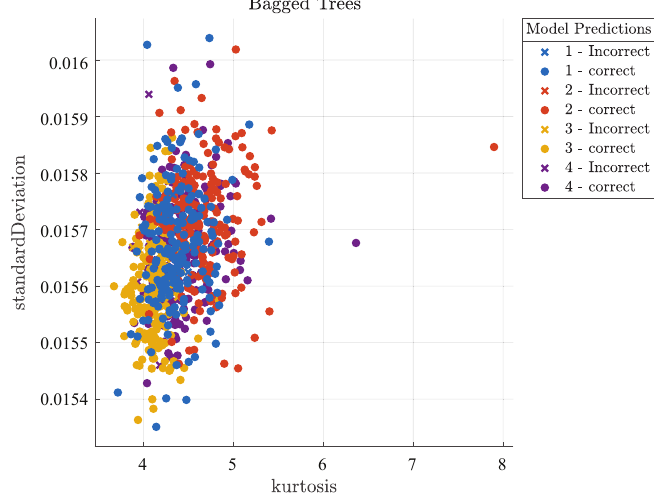
Figure 20. Scatter diagram of